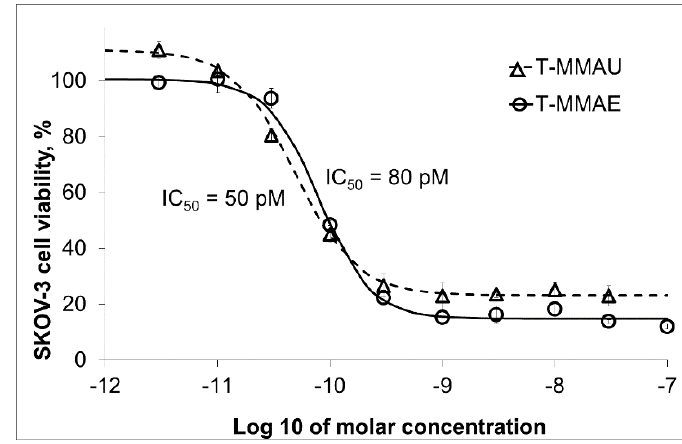
Figure 5. Trastuzumab antibody (T)-payload conjugates 3 and 4 have nearly comparable cytotoxicity against the HER2-expressing SKOV-3 cells, whereas they are between 10-fold (against MMAE) and 20,000-fold (against MMAU) more cytotoxic than the free payloads. In the assays, different concentrations of ADCs were applied to the cell culture medium and the cell viability was evaluated after 72 h incubation. The graph shows the average values of three parallel experiments. Error bars show the standard deviation.